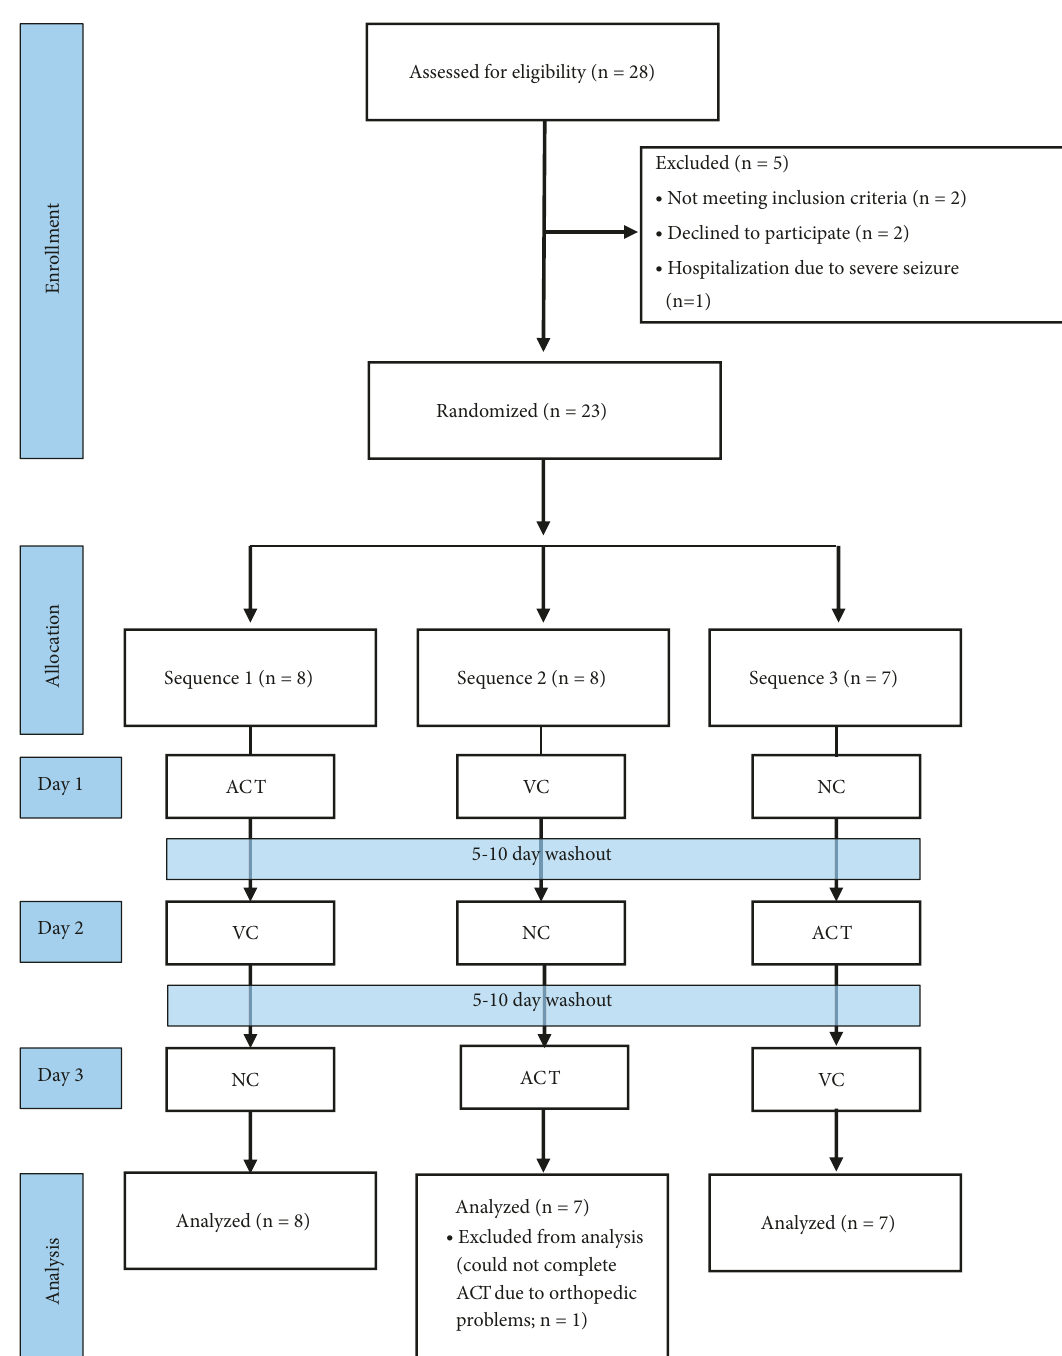
Figure 1: Study flow diagram indicating inclusion, exclusion, and